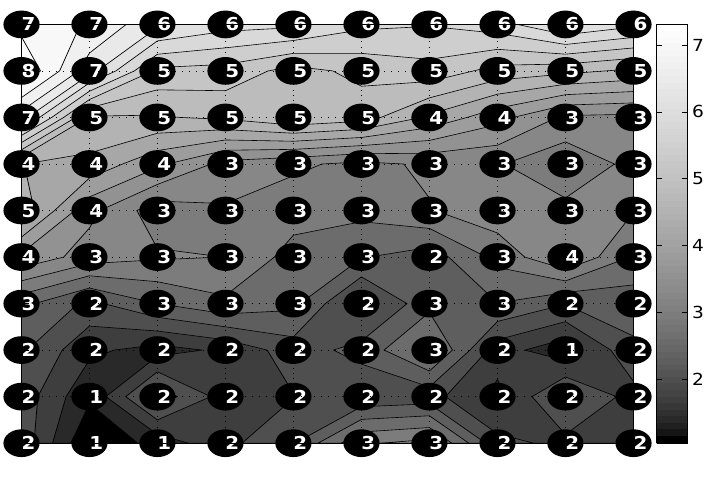
Figure 7. The contour map of average breathing ranges inside the selected area of the chest for the given grid density with their values (in mm) evaluated over the time range of 180